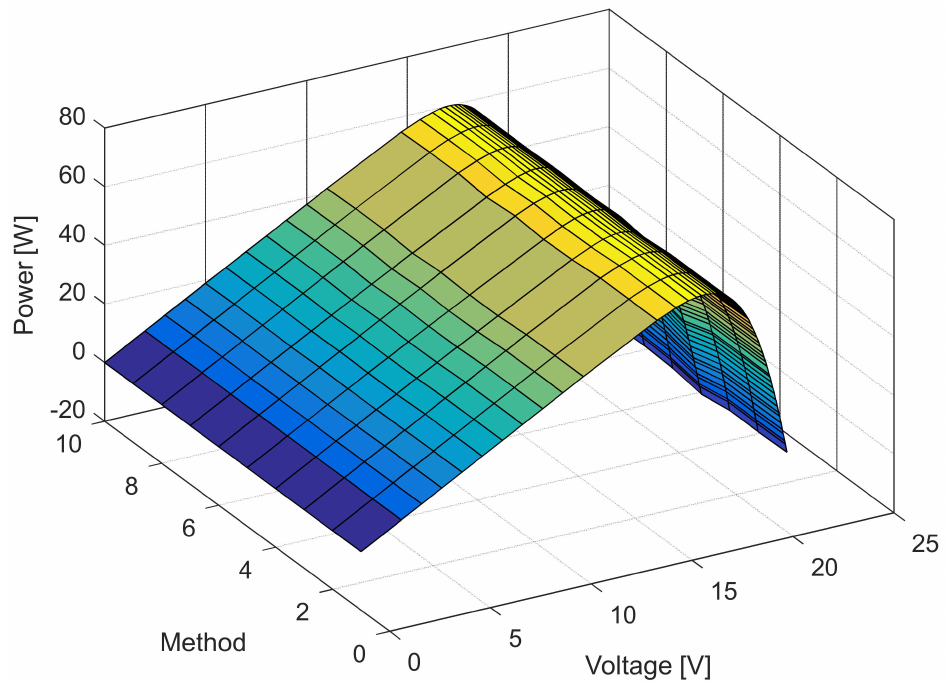
Figure 18. Power–voltage characteristics for the methods listed in Table